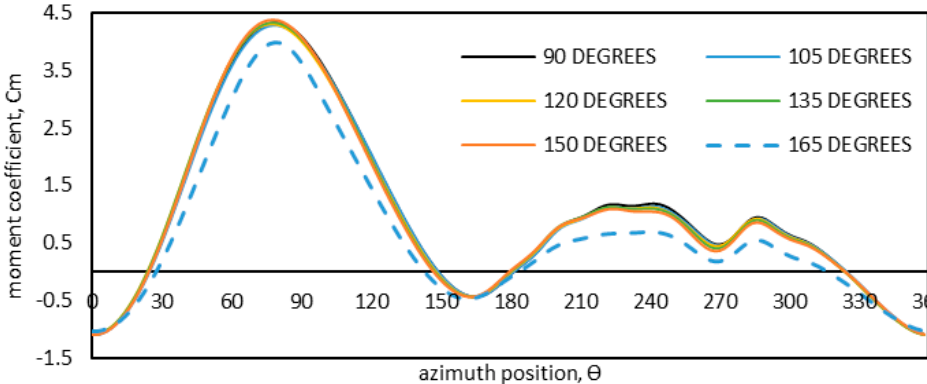
Figure 20. Torque ripple at various oblique angles (90° to 165°).